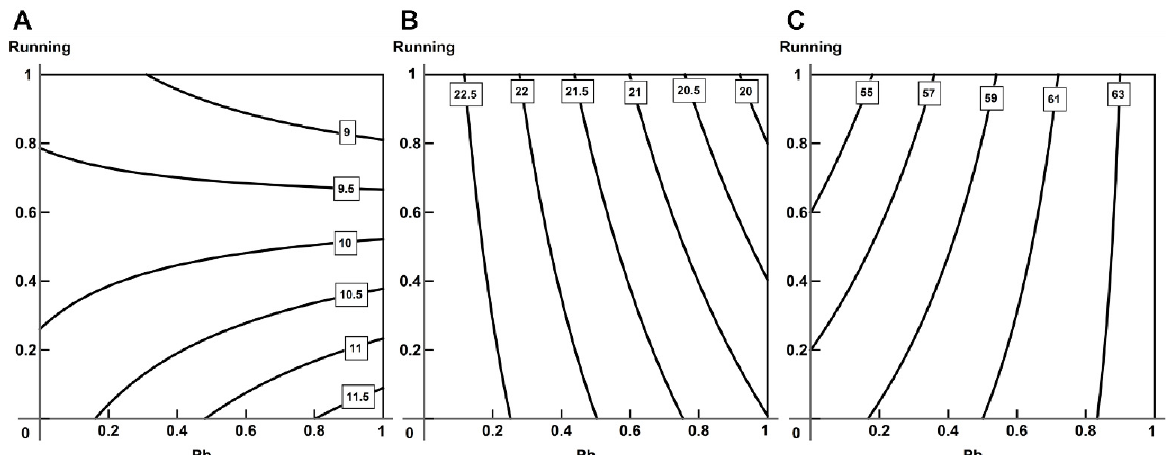
Figure 13. Variability of combined action of running and lead intoxication on active tension in ( A ) trabecules (single-factor effect of lead at low doses changes to opposite action at high doses) and ( B ) papillary muscles (opposite action at high doses of lead changes to its single-factor action at high doses) at L = 0.95 Lmax . Regression equations are y = 117.5 − 50.120 x 1 − 7.864 x 2 + 29.557 x 1 x 2 for and for ( B ).